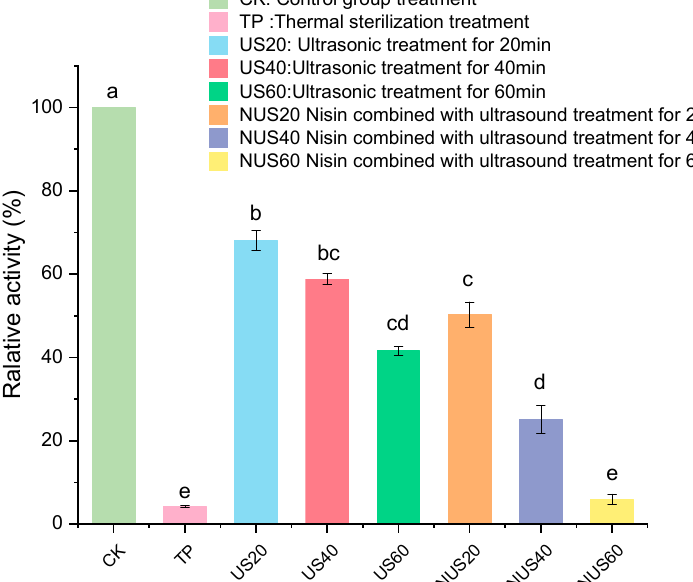
Figure 1. Effects of different sterilisation treatments on the relative PPO activity in CLB. CK represents the untreated group; TP represents the heat treatment group; US20, 40, and 60 represent the ultrasonic treatment groups for 20, 40, and 60 min alone; and NUS20, 40, and 60 represent the ultrasonic combined nisin treatment groups for 20, 40, and 60 min. Different letters indicate significant differences between the means ( p < 0.05).